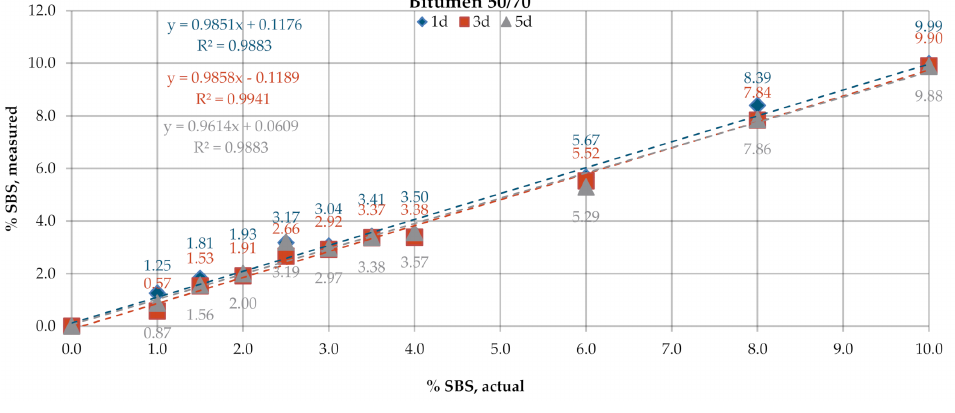
Figure 7. SBS contents in bitumen 50 / 70, transmission mode.